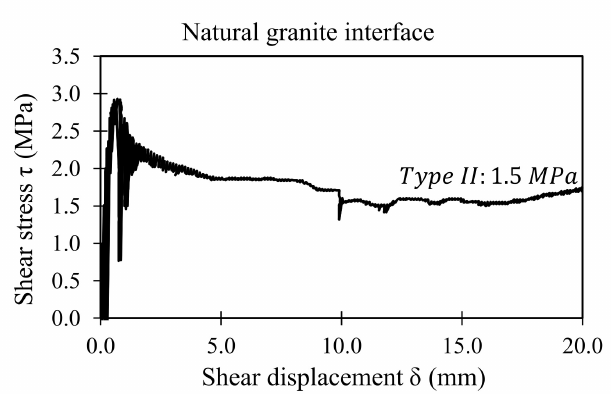
Figure 11. Shear evolution—Type I (natural granite interfaces).